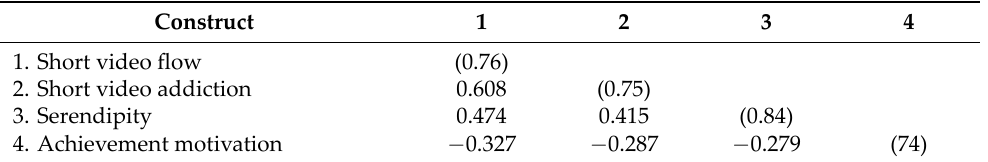
Table 3. Discriminant Construct